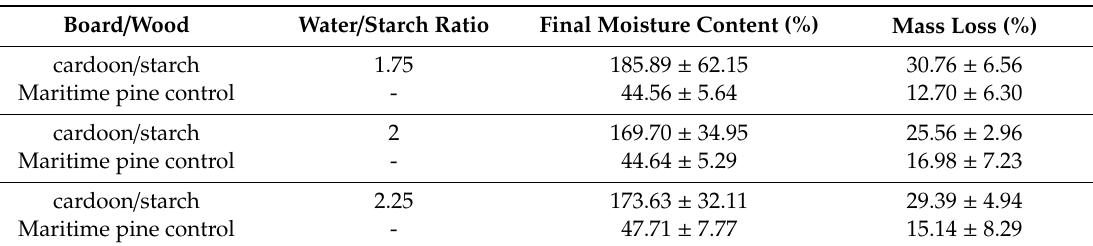
Table 3. Average results of mass loss (% of initial dry mass) and final moisture content of the particleboards bonded with a potato starch and their paired maritime pine controls exposed to G. trabeum ( n = 10). All adhesive formulations had a starch / cardoon ratio of 0.8 and cs / starch ratio of